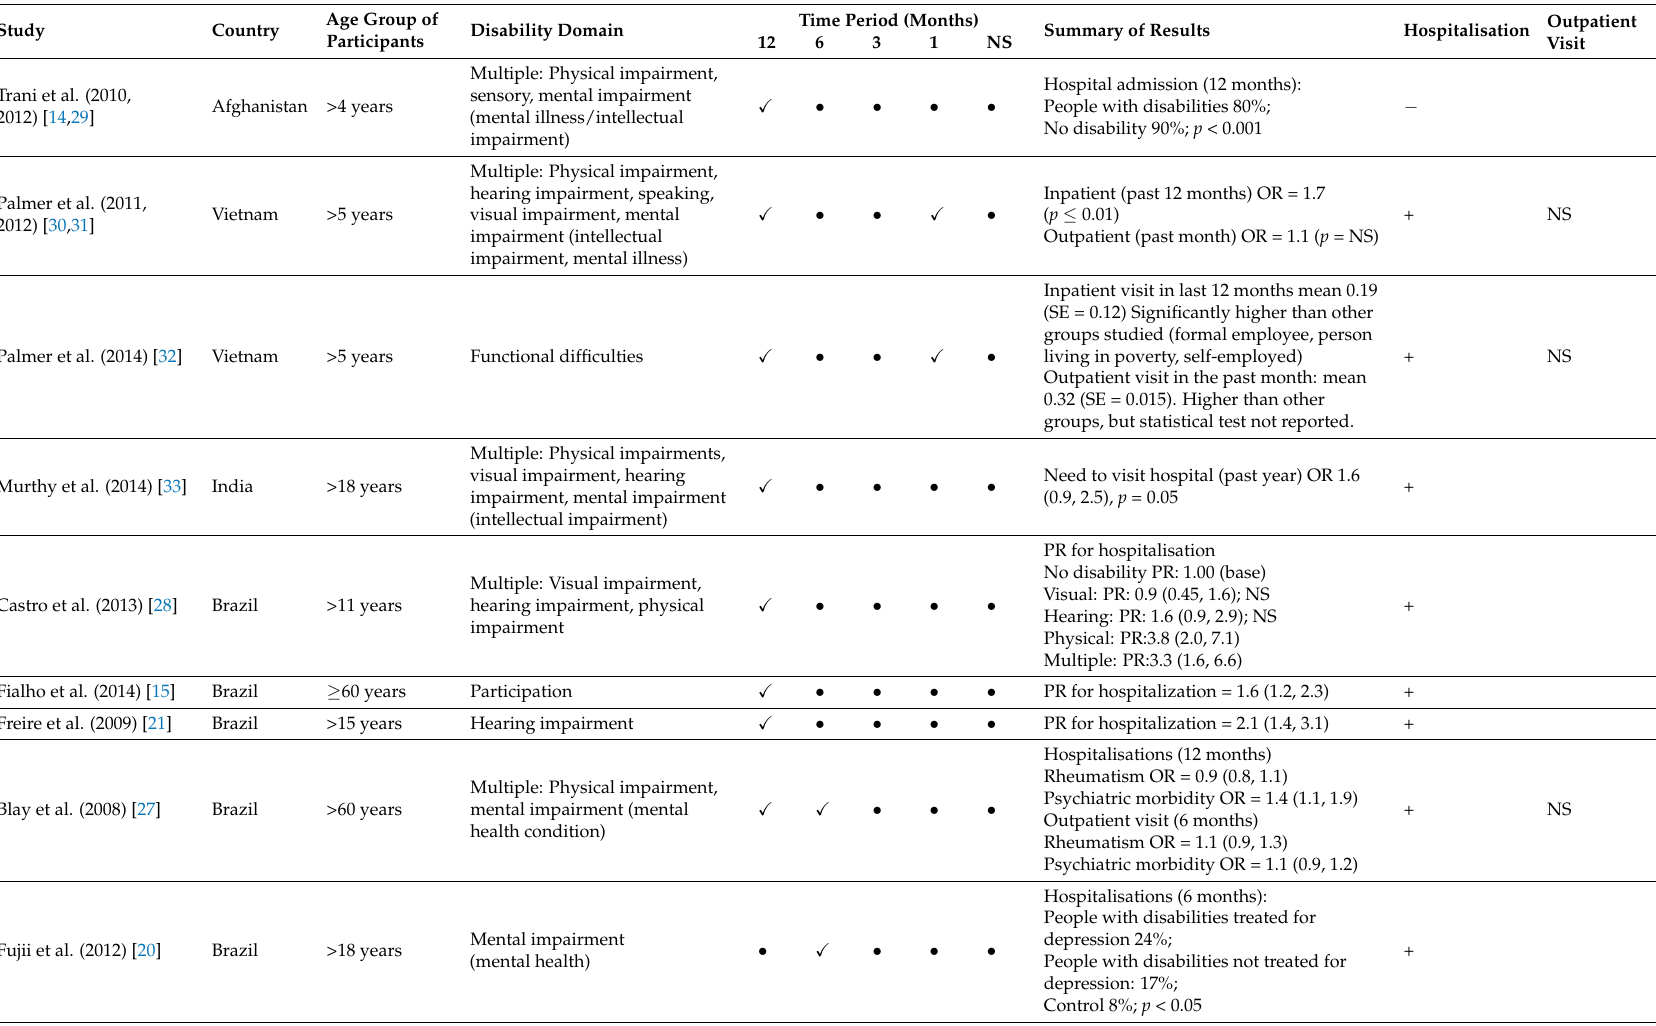
Table 4. Comparison of utilisation of hospital services between people with and without